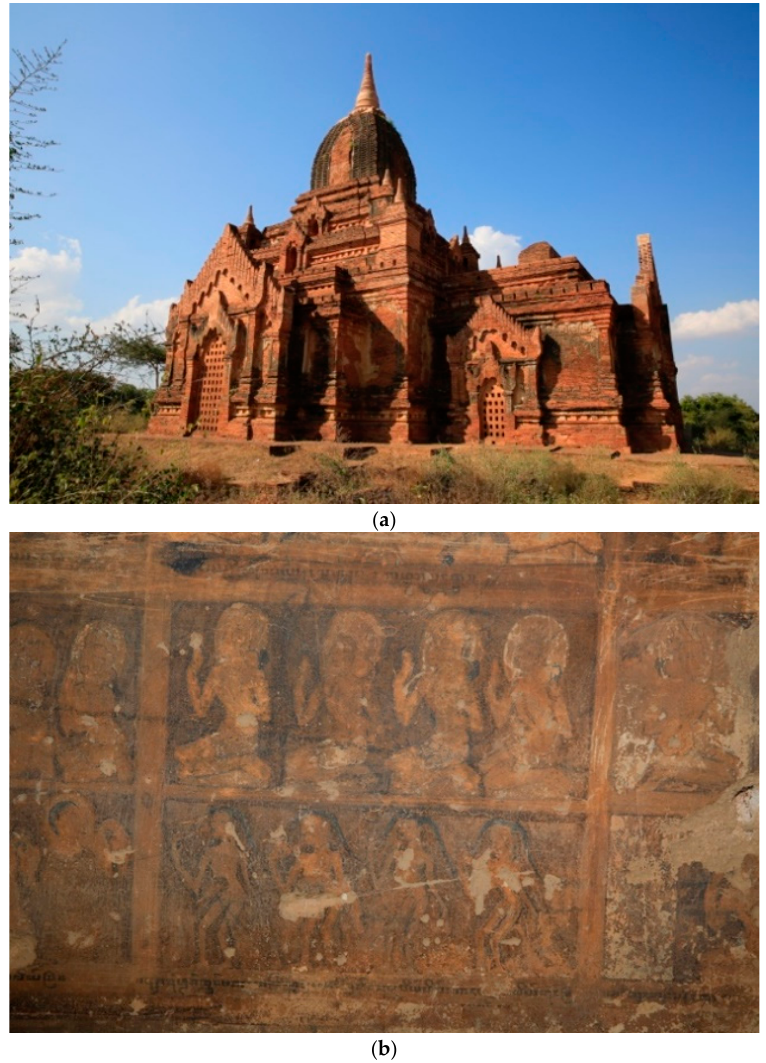
Figure 21. ( a ) Pagan, 13th century, Theinmazi. ( b ) Pagan, 13th century, Theinmazi. The fate of Petas in a story inscribed to recount their starvation, alleviated by donations made by family members. The image shows them as ghosts as well as heavenly mansion dwellers.